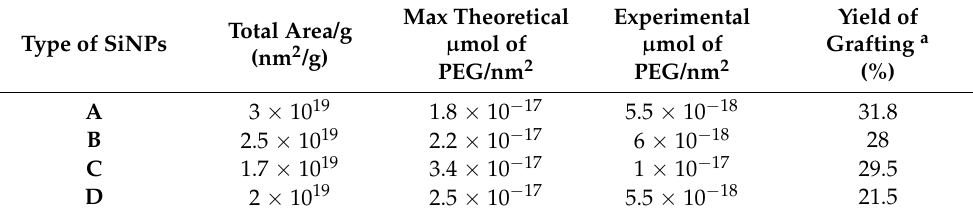
Table 2. Accessible silica surface and theoretically vs. experimentally number of mol of PEG/nm 2 .